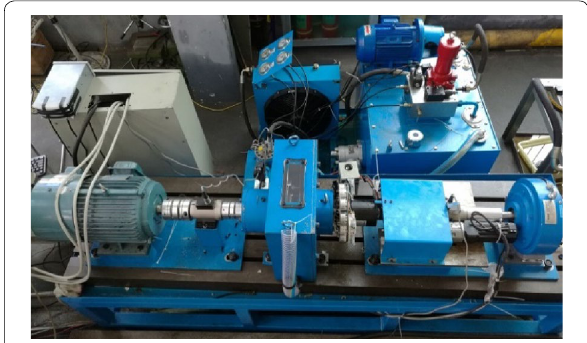
Figure 3 Experimental device for the cutter-head driving